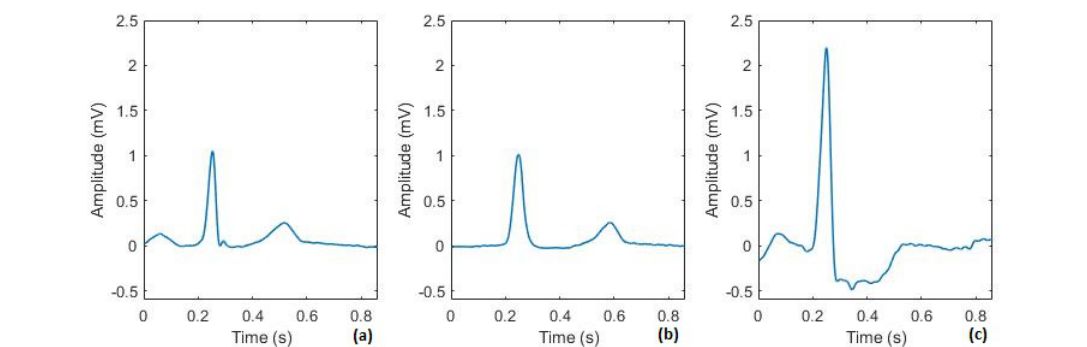
Figure 3. Examples of cardiac cycle (CC) waveforms for beats classified as normal ( N ; panel ( a )), supraventricular ( S ; panel ( b )) and ventricular ( V ; panel ( c